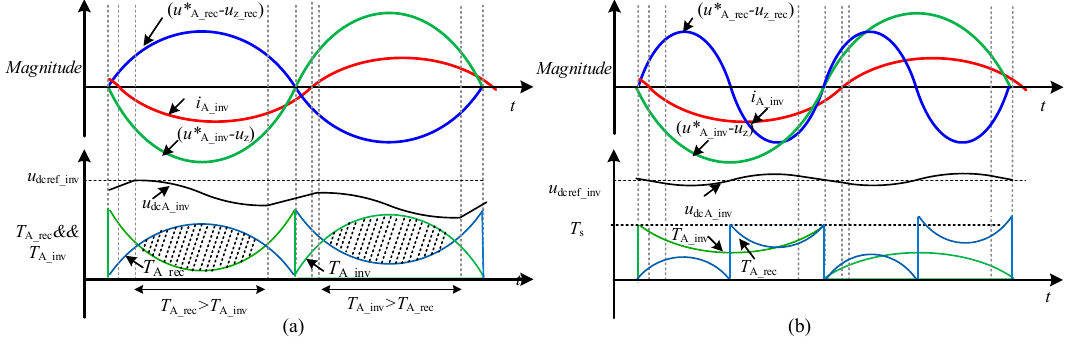
Figure 9. Analysis of voltage deviation with C A_inv . ( a ) When Sgn|( u *A_rec − u z_rec )| = − Sgn|( u *A_inv − u z )|; ( b ) when m inv < 1 − m rec .